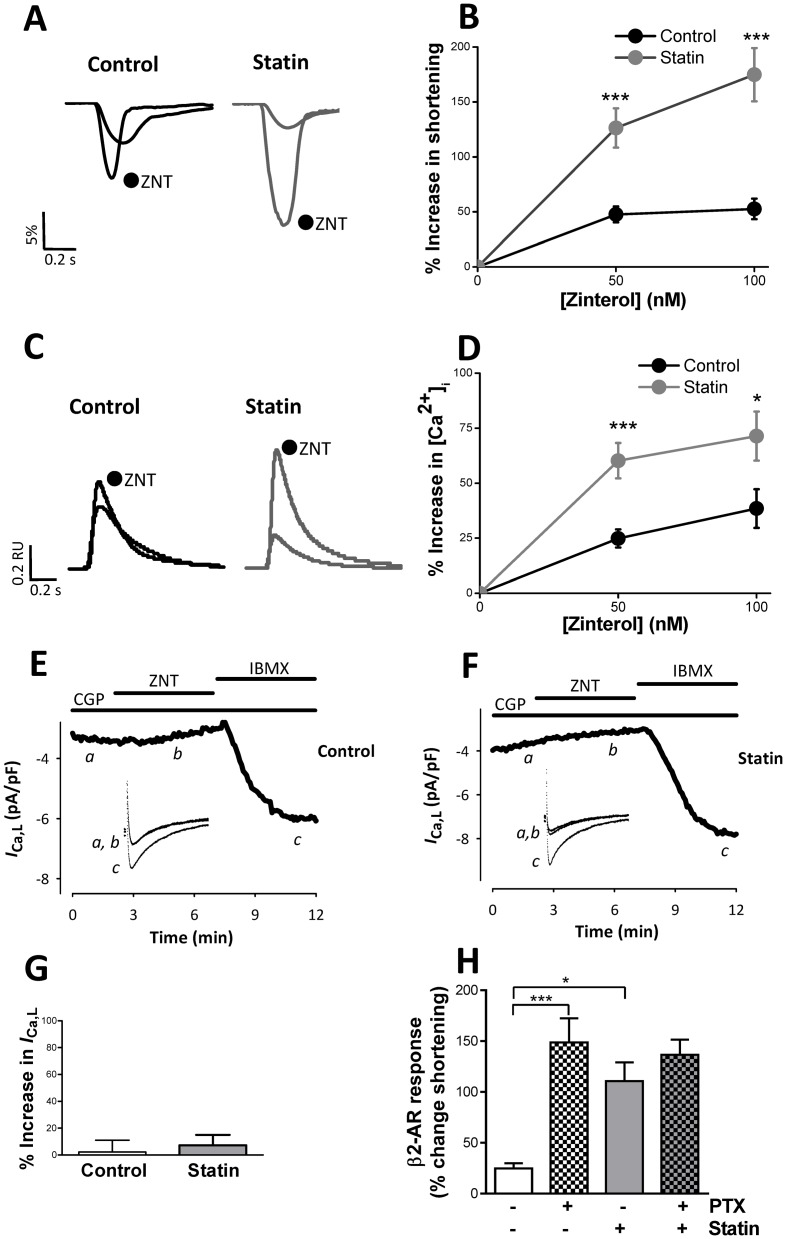
The effect of simvastatin treatment on the response to selective β2-AR stimulation.A, B. Representative traces and mean data of the response of shortening (expressed as a % of resting cell length) to selective stimulation of β2-AR with 100 nM zinterol (ZNT) in the presence of 10 nM CGP20712A. *** P<0.001 vs control. C, D. Representative traces and mean data of the response of [Ca2+]i transient amplitude to selective β2-AR stimulation. Data are from 24–30 myocytes from 7 hearts. * P<0.05; *** P<0.001 vs control. E, F, G. Representative traces and mean data of the response of I
Ca,L to selective stimulation of β2-AR with 100 nM ZNT in the presence of CGP20712A (CGP). Neither control nor simvastatin-treated myocytes showed a significant response of I
Ca,L to selective β2-AR stimulation (one sample t-test; data from 13–15 myocytes from 7–8 hearts), although in every case a robust I
Ca,L response to 100 µM IBMX was evoked. H. Bar graph shows the effect of pertussis toxin (PTX) treatment on the % change in shortening in response to β2-AR stimulation with 100 nM ZNT plus CGP. n = 25 myocytes from 5 hearts. * P<0.05; *** P<0.001, 2-way ANOVA.